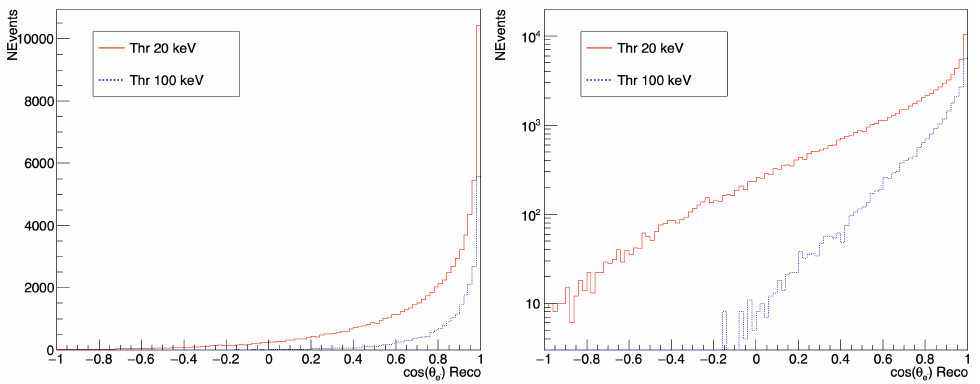
Figure 16. Angular distribution for electron recoils induced by solar neutrinos for 20 keV and 100 keV energy thresholds with a 30 ◦ × 30 ◦ angular resolution, shown on the right in log